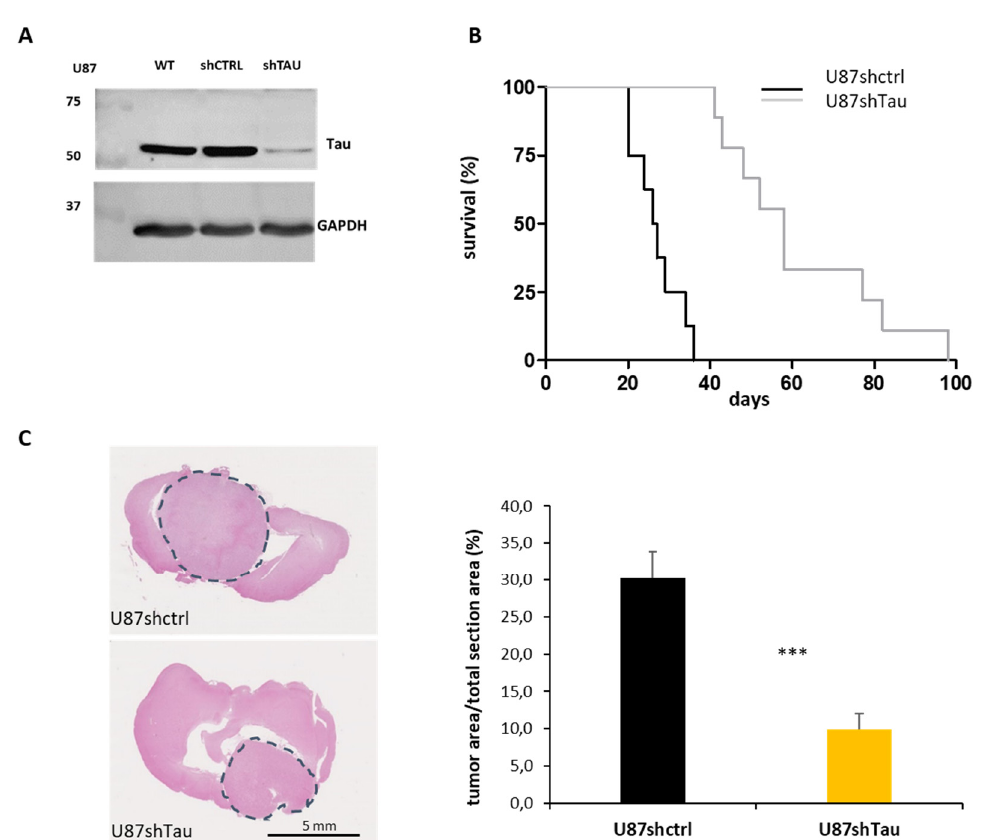
Figure 1. Tau down-regulation reduces in vivo tumorigenicity. ( A ) Western blot analysis for Tau expression of U87 wild-type (WT), shctrl and shTau cell total protein lysates (30 µ g). GAPDH was used as the loading control. ( B ) Kaplan–Meier survival plot of nude mice intracranially grafted with U87shctrl and U87shTau cells. ( N = 9 mice, for each group). ( C ) Histological analysis of brains from mice intracerebrally grafted with U87shctrl and U87shTau cells (H.E. staining). Left: representative images of coronal sections, the grey circles indicate tumor tissue. Right: quantification of the area occupied by the tumor at the maximal brain tumor dimensions in the sections. Results are expressed as the percentage of apparent tumor area on brain area section ( N = 8 mice for each group, *** p < 0.001).